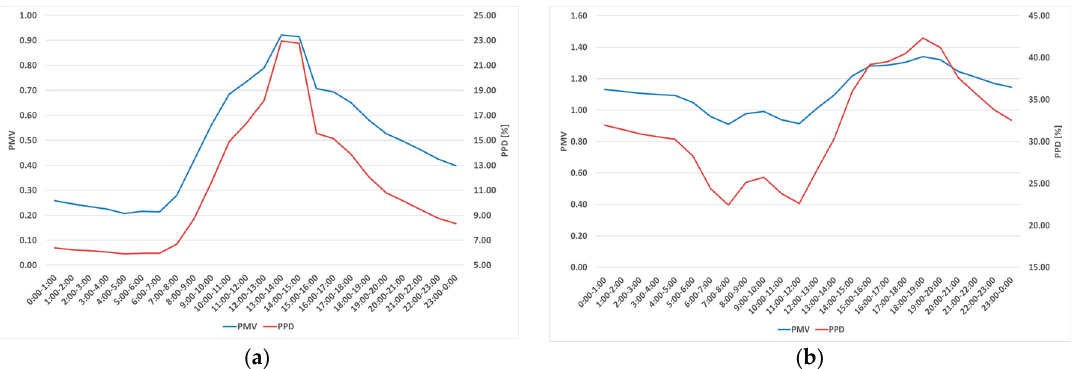
Figure 12. Variation of PMV index in Building B during a typical day in: ( a ) winter (1 March 2016) and ( b ) summer (14 September 2016) along with the respective PPD rates.